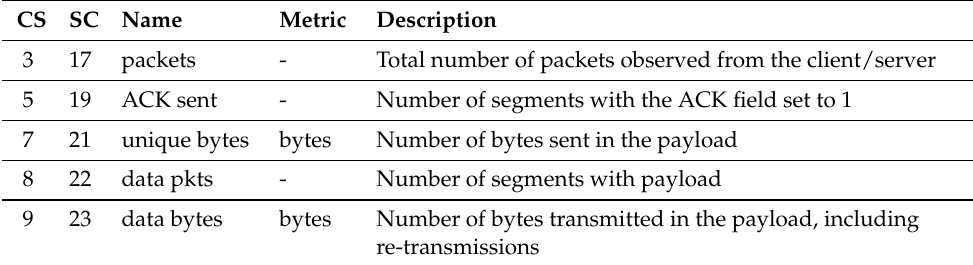
Table 1. Tstat selected features for cryptomining attack detection.